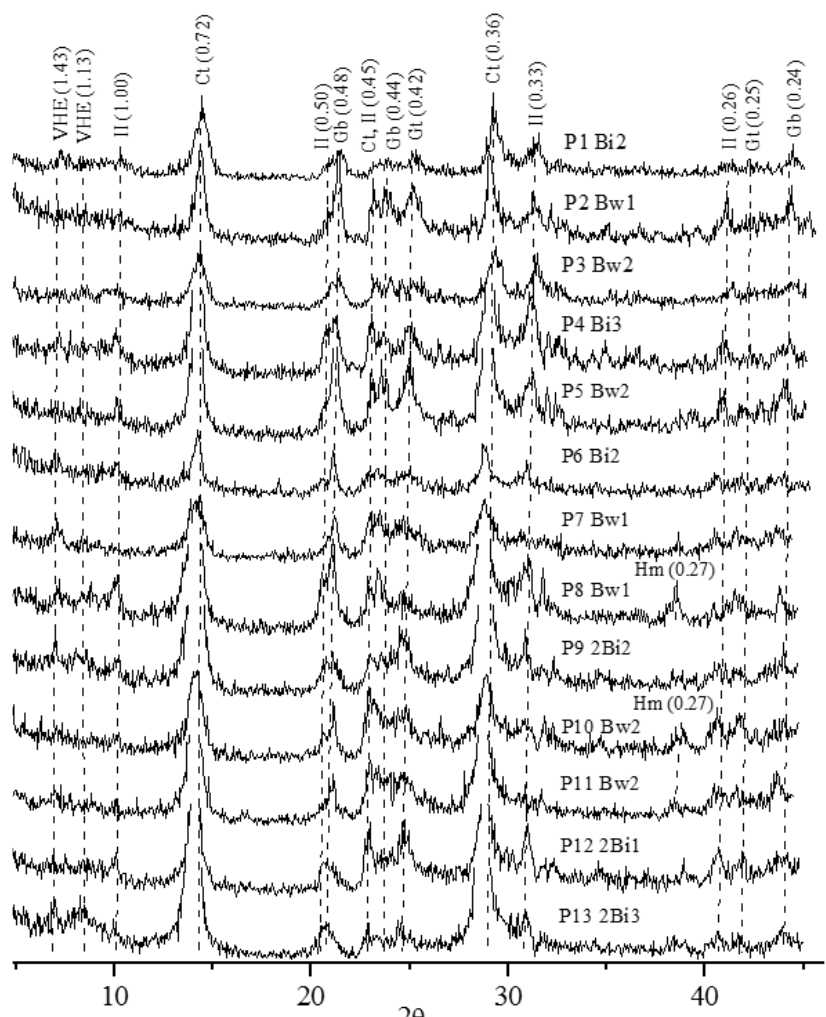
Figura 2. DRX da fração argila (horizonte B) de Latossolos e Cambissolos desenvolvidos de rochas pelíticas do Grupo Bambuí. VHE: vermiculita com Al-hidroxi entrecamadas; II: ilita; Ct: caulinita; GB: gibbsita; Gt: goethita; Hm: